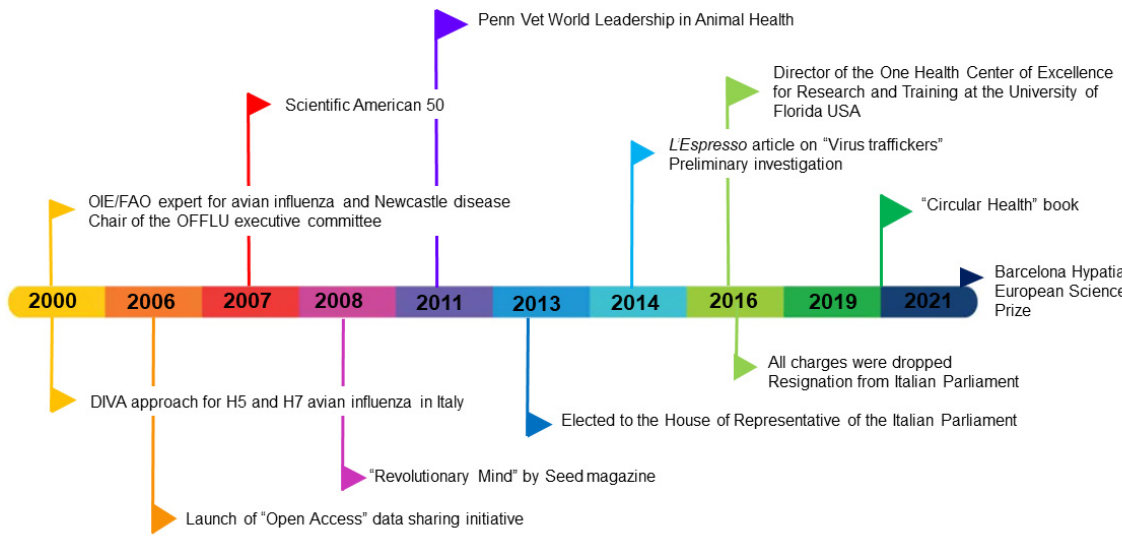
Figure 2. Timeline of Dr. Ilara Capua’s career from 2000 until 2021.